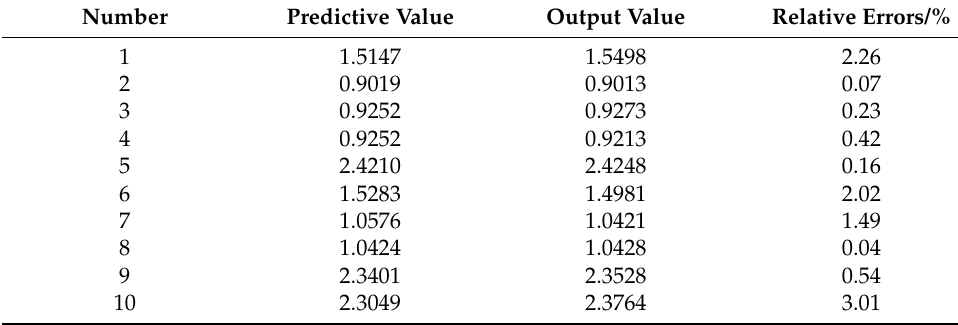
Table 6. Prediction results of BP neural network